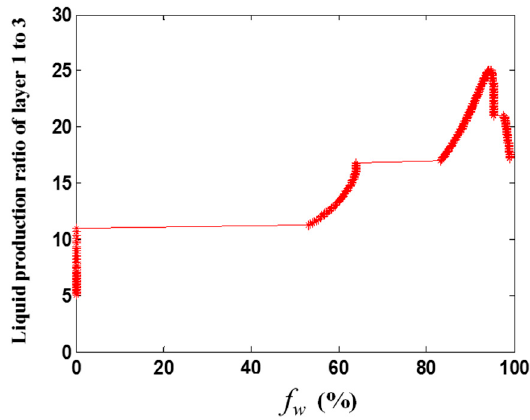
Figure 7. Ratio of liquid production between high and low permeability layers (best to the worst) as the water cut ranging from 0 to nearly 100%.